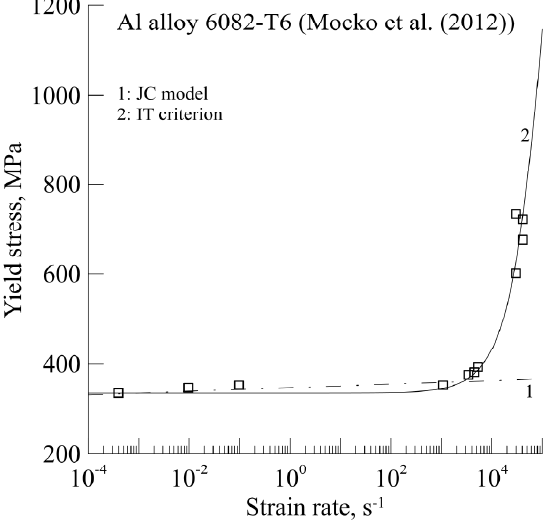
Fig. 3. Rate dependence of yield stress of Al alloy 6082-T6 (data from [48]), plotted on JC model (1 line) and IT criterion (2